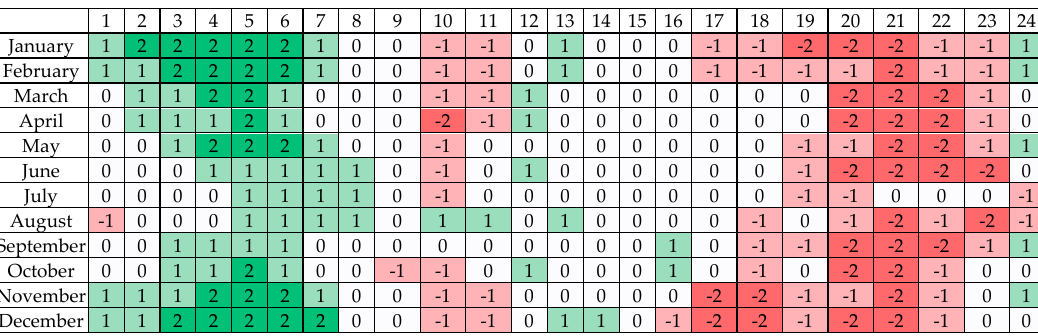
Figure 17. Strategy to optimise the load shifting: Saturdays. ( − 2, Green) Strong Load reduction; ( − 1, Light Green) Weak Load reduction; (0, White) No Load variation; (1, Light Red) Weak Load increase; (2, Red) Strong Load increase.